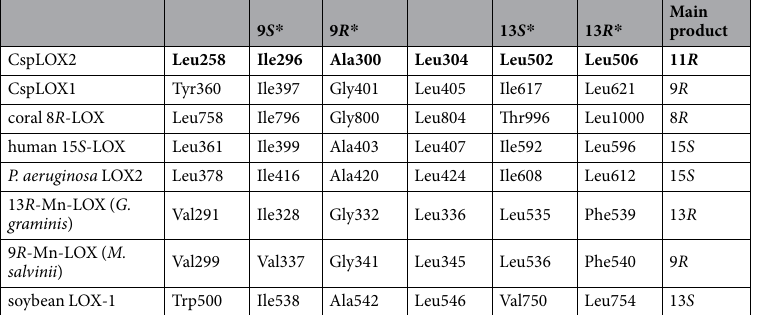
Table 1. Residues corresponding to the active site clamp in other LOX. While most of these residues are rather conserved among LOX, Leu502 and Leu258 show a higher variability. The specificities observed by exchange of these residues in CspLOX2 are shown with an asterisk. these residues in CspLOX2 are shown with an asterisk.